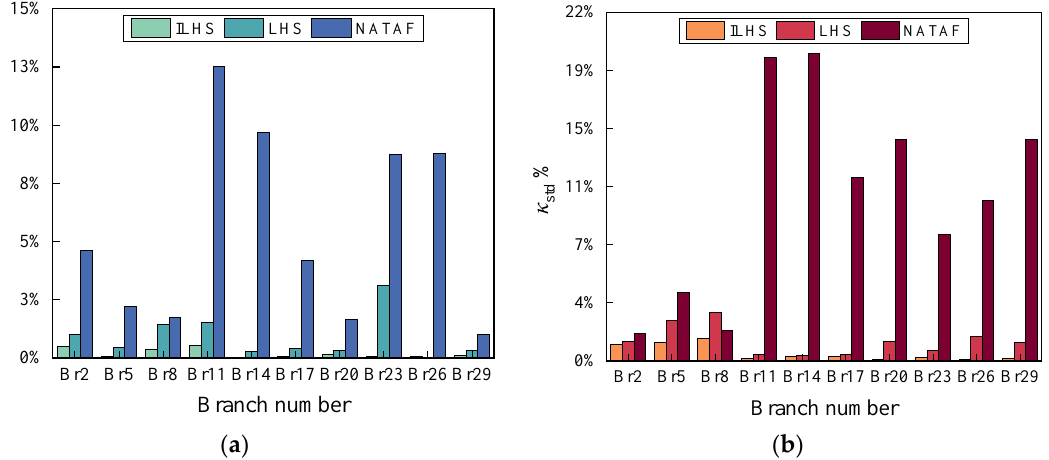
Figure 9. Comparison of ( a ) the mean error and ( b ) the standard deviation error of the AC branch active powers.